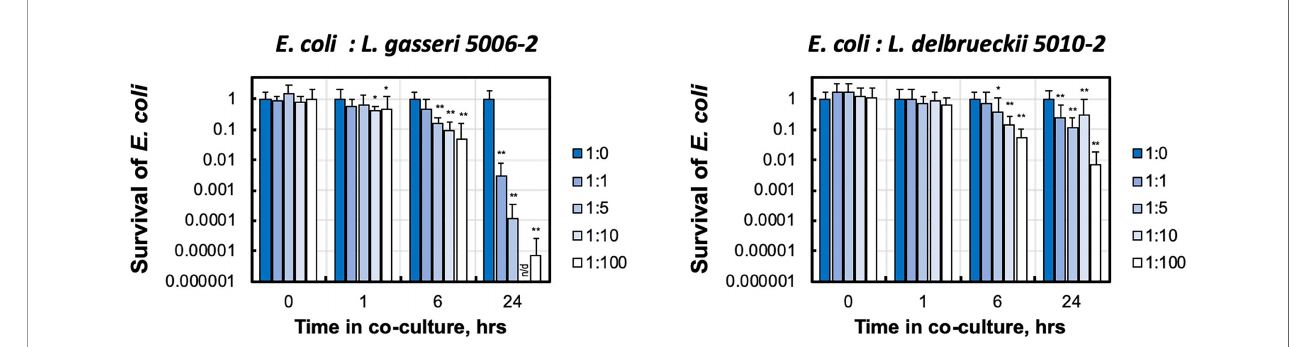
FIGURE 4 | Urinary lactobacillus strains inhibit E. coli growth when co-cultured in liquid medium. Uropathogenic E. coli CFT073 was grown in presence of increasing amounts of initial lactobacilli ( L. gasseri 5006-2 and L. delbrueckii 5010-2) with ratios 1:0, 1:1, 1:5, 1:10, and 1:100 estimated by the OD600 measurements. E. coli survival was measured by LB plating of serial dilutions for CFU counting and compared with growth of E. coli only culture (1:0). Survival is calculated as culture density normalized to E. coli only culture. Error bars show only positive arm of standard deviation for three biological replicates. *p < 0.05 and **p < 0.01 and indicate a signi fi cant decrease from E. coli grown in the presence of lactobacilli. Over the course of this experiment E. coli for lactobacilli-free condition (1:0) grows from ~ 2.5- 3.4×10 6 to ~ 8.4 - 9.7×10 8 CFU/mL densities. n/d – the limit of detection of our CFU counting was at about 500 CFU/mL, corresponding to ~ 0.5×10